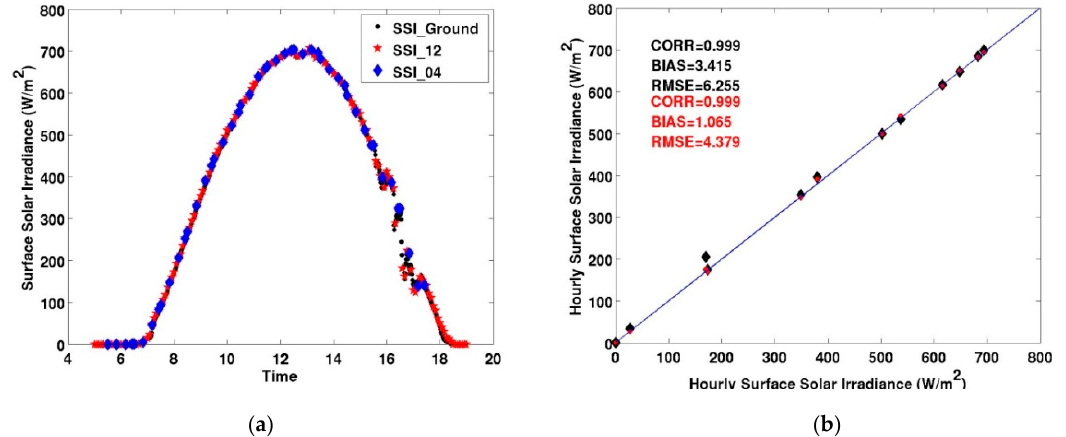
Figure 7. Data from 14 March 2018 at JRC. ( a ) Surface solar irradiance estimate by AMESIS based on 4- (SSI_04) and 12- (SSI_12) hourly samples, against measurements by ground-based pyranometers (SSI_ground); ( b ) Scatter plot of the AMESIS hourly surface solar irradiance estimates based on 4- (black diamonds) and 12- (red circles) hourly samples against the irradiance measured with the